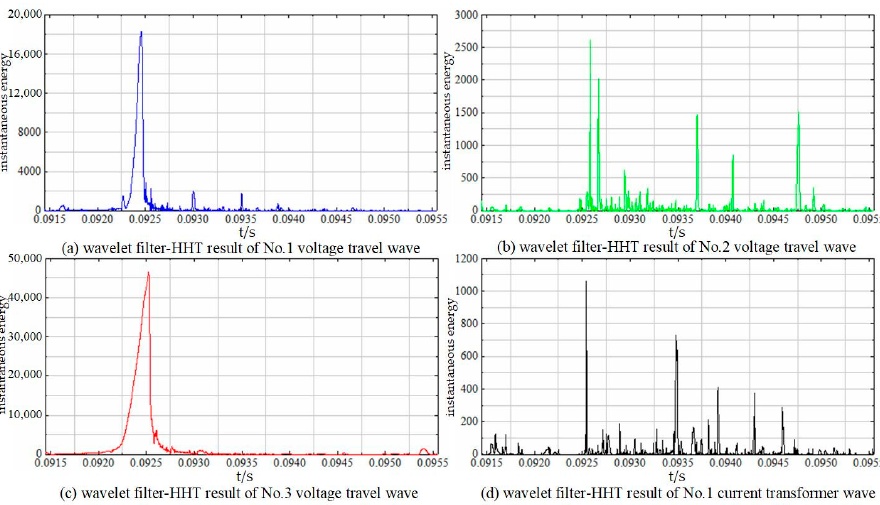
Figure A4. Results of wavelet filter HHT transform in condition 1.